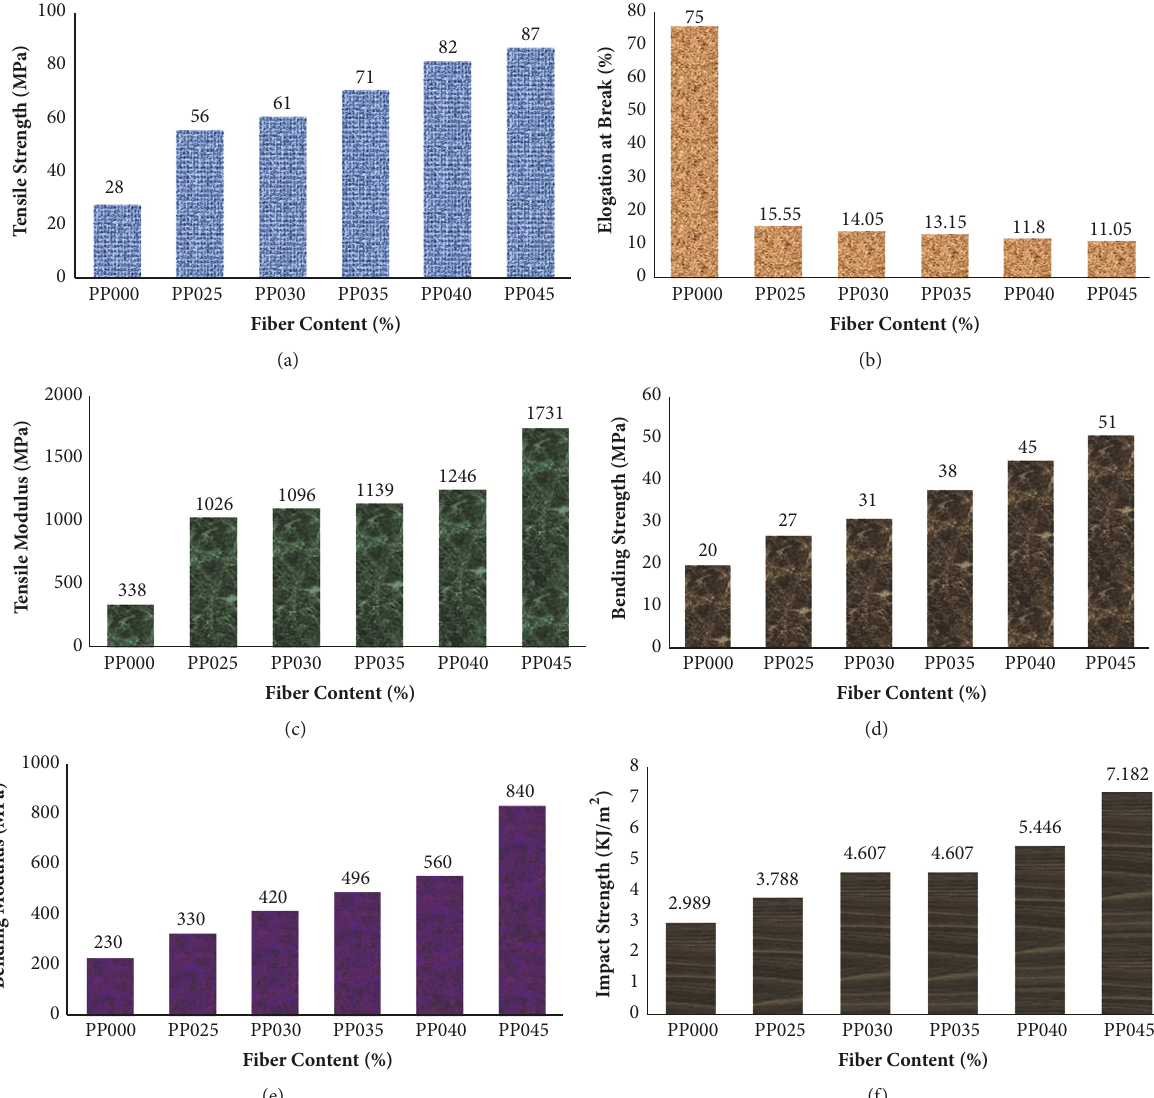
Figure 2: Effect of fiber content on the mechanical properties of PALF/PP